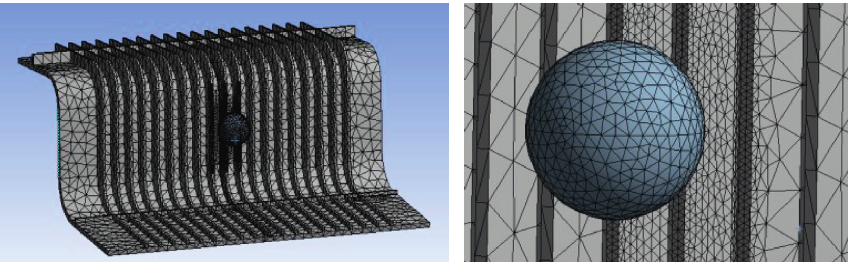
Figure 11: Simplified finite element model and mesh of oil